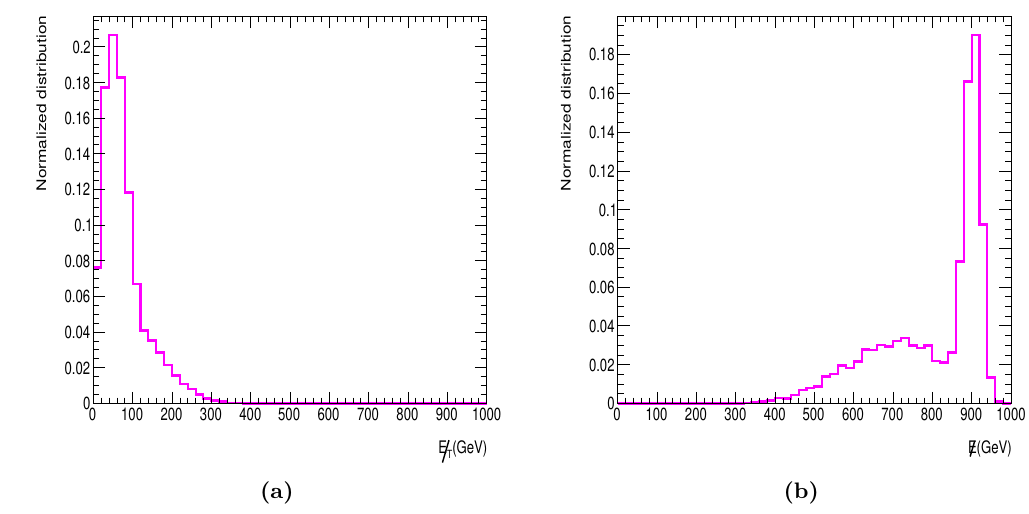
Figure 3. Normalized (a) /E T and (b) /E distribution for two component scalar DM scenario with { m DM , m DM , ∆ m 1 , ∆ m 2 } = { 50 , 390 , 100 , 100 } GeV where HDSP pair production and subsequent 1 2 decay chain is chosen as in figure 2 (see text). The production cross-sections for both the HDSP √ pairs are assumed equal at s = 1000